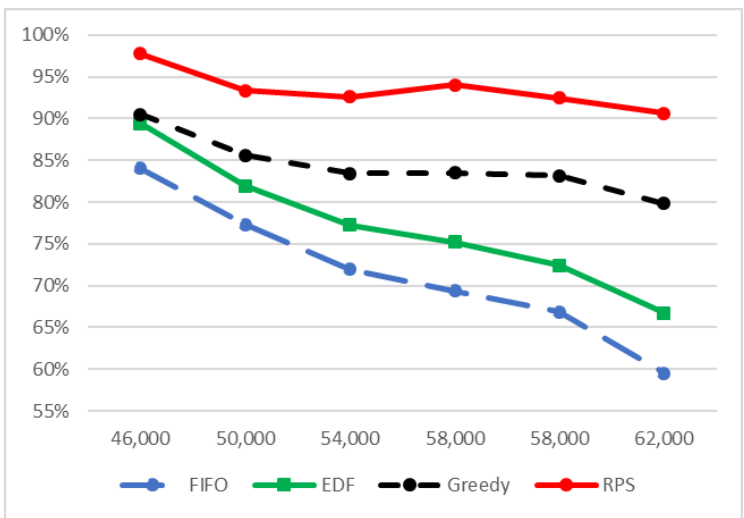
Figure 8. Processing time in seconds with different window sizes ( λ a = 56,000).